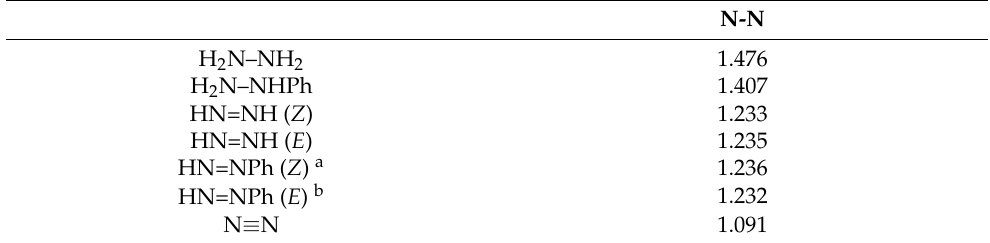
Table 4. Length of the N-N bond (Å) in selected small molecules, calculated at the ω B97M-D4/cc- pVTZ